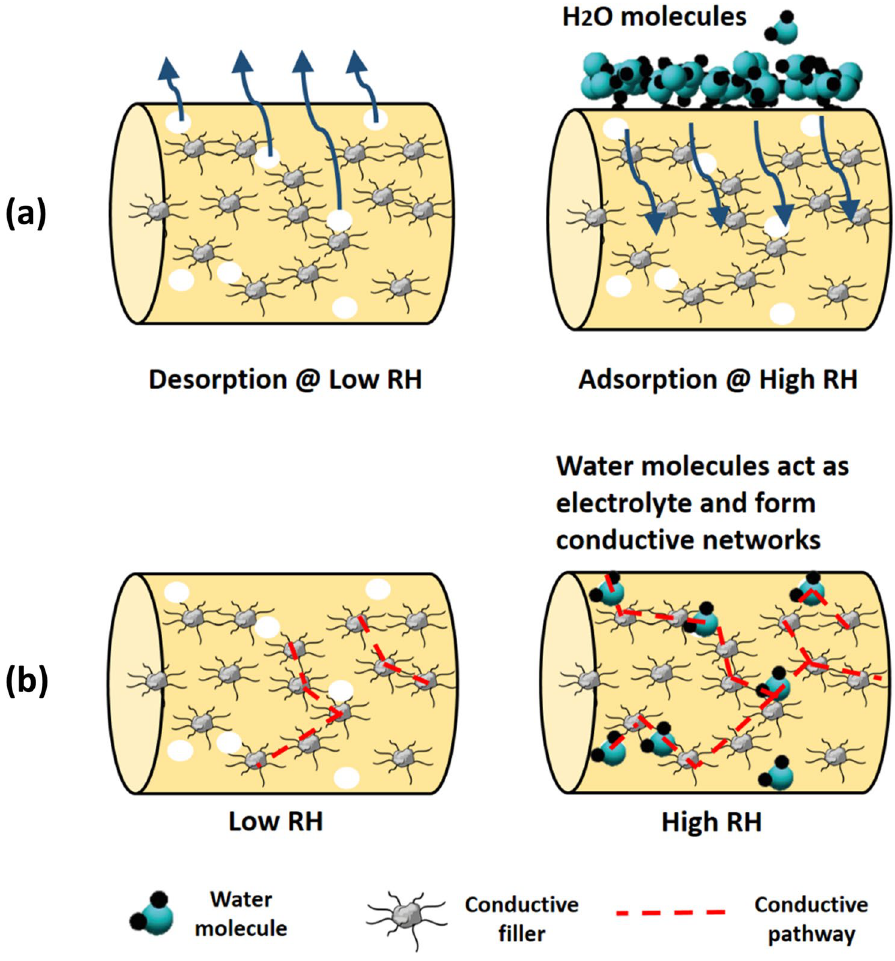
Figure 7. Schematic description of the effect of humidity on (a) the microstructure of the matrix (b) conductive paths in the matrix. This figure was created using Sketchup version 2017 (https:// www. sketc hup. com), Microsoft PowerPoint version Microsoft 365 (https:// www. micro soft. com/ en- us/ micro soft- 365/ power